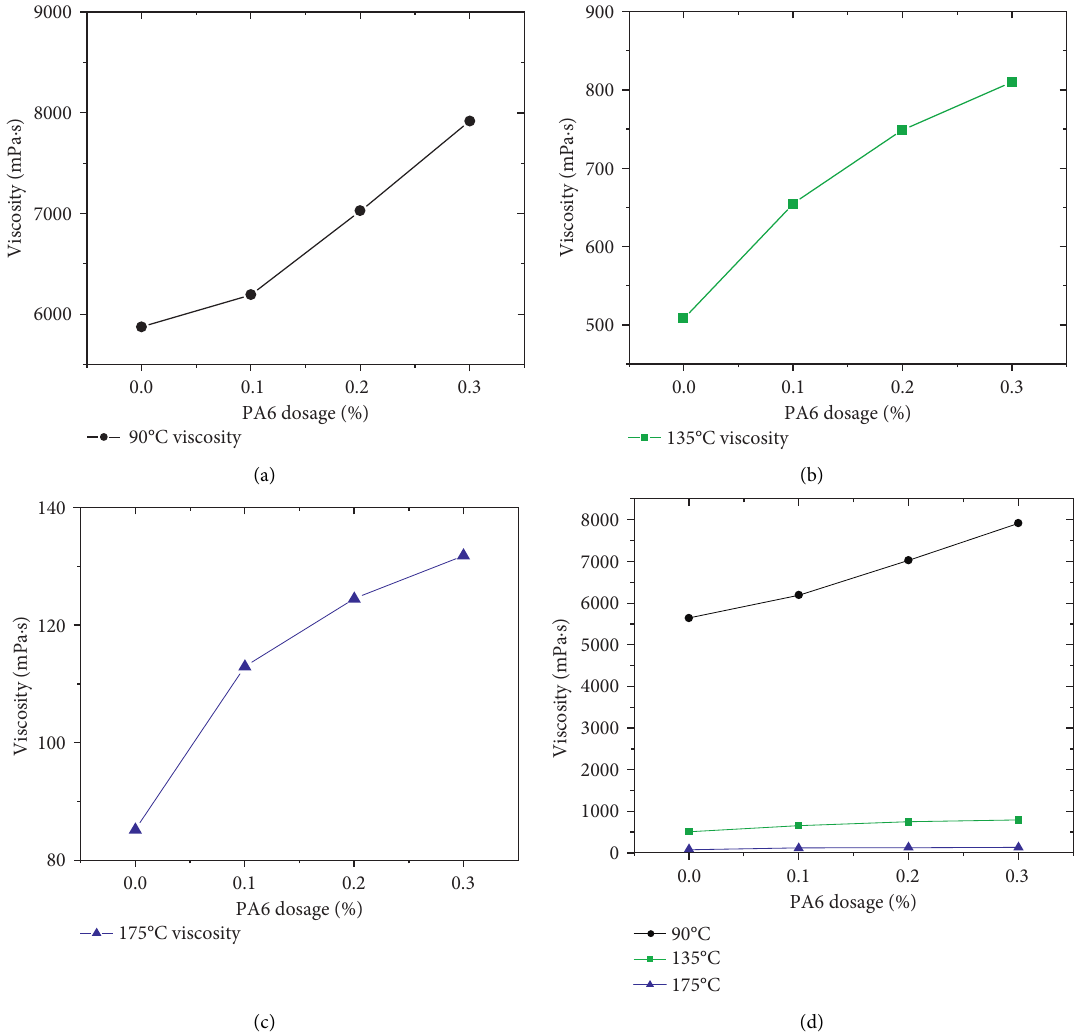
Figure 7: Brookfield viscosity of PA6 modified asphalt and 70#